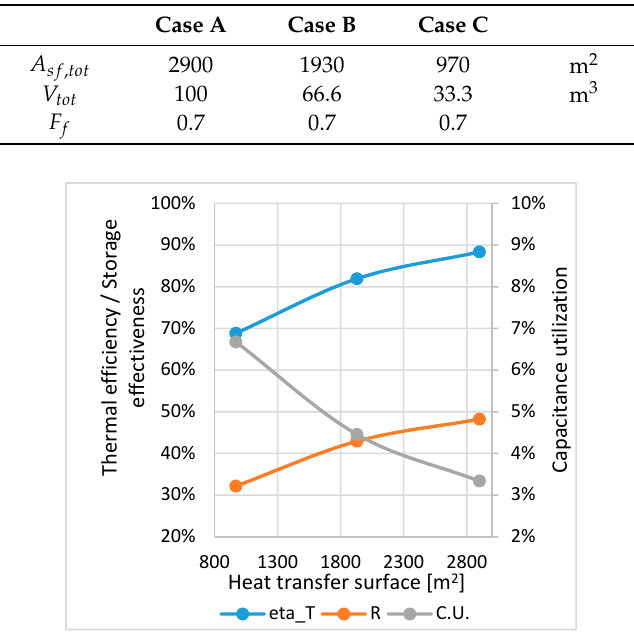
Figure 6. Thermal efficiency, storage effectiveness, and capacitance utilization averaged ( τ =20’).